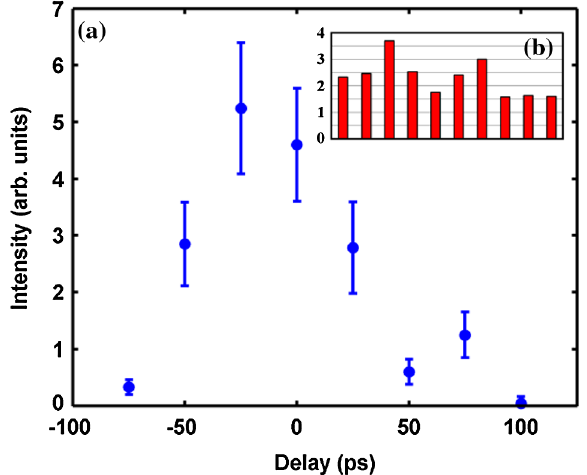
FIG. 4. (a) Measured laser intensity as a function of the delay between the peak of the prepulse and the short pulse. The points are the average of 4–15 laser shots and the error bar represents 1 standard deviation. (b) Measured shot-to-shot intensity variation of the (cid:1) ¼ 8 : 85 nm laser operating at a 1-Hz repetition rate.